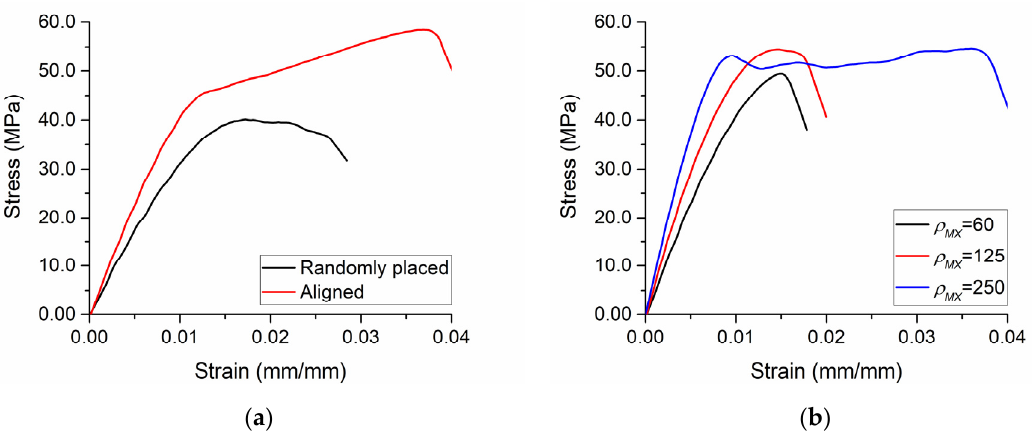
Figure 4. The influence of: ( a ) geometrical orientation of the inclusions at ρ G = 500, ρ MX = 125, f G = 0.1%, f MX = 1.6%, and E MX = 0.5 E m ; ( b ) the aspect ratio of aligned MXene inclusions at ρ G = 500, f G = 0.1%, f MX = 3.2%, and E MX = 0.5 E m .